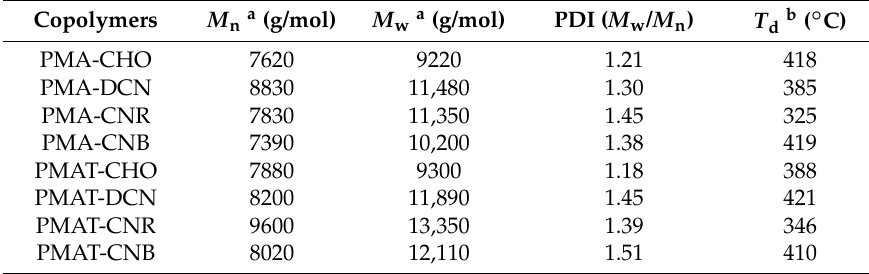
Figure 1. FT-IR spectra of ( a ) PMA-series and ( b ) PMAT-series. The monomers N -(2-ethylhexyl)-3,4- bis{4-[(3-octylthien-2-yl)phenyl]}maleimide (TML), 4-[ N , N -di(4-bromophenyl)amino]benzaldehyde (TA) and 2-(2-{4-[ N , N -di(4-bromophenyl)amino]phenyl}ethenyl)thien-5-al (TAT) are incorporated for comparison. Table 1. Molecular weights and thermal properties of